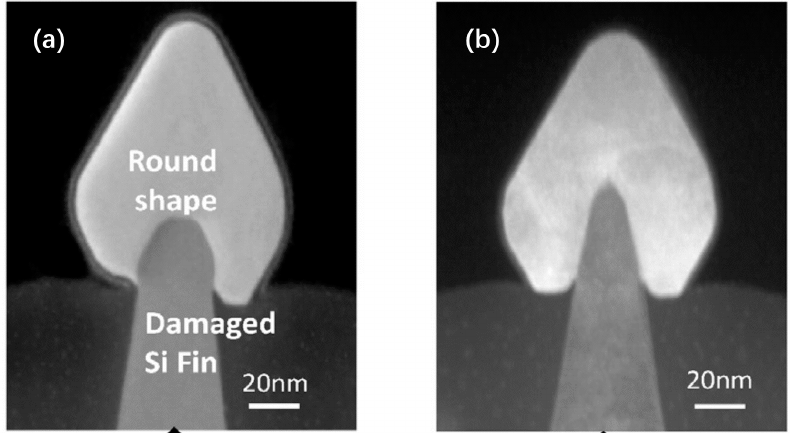
Figure 19. HRTEM cross-section micrographs of the Si-fins with different prebaking temperatures as follows: ( a ) at 825 °C and ( b ) 800 °C [104].